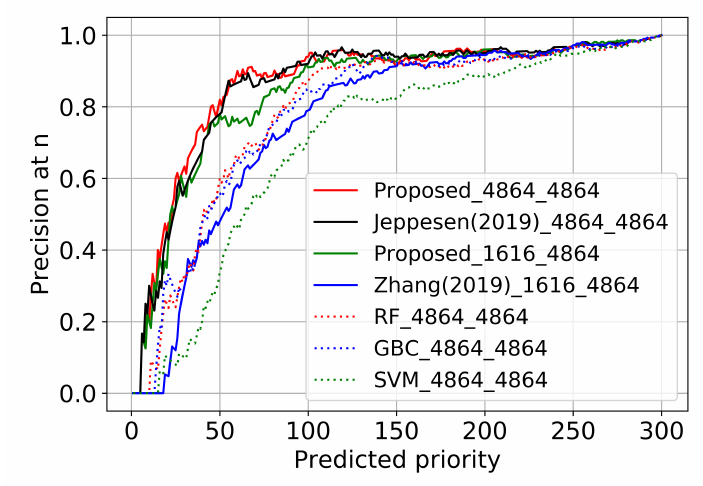
Figure 12. Precision at n for NU-Net (proposed), RS-Net (Jeppesen, 2019), without patch decomposition, and NU-Net (proposed) and L-Unet (Zhang, 2019) with patch decomposition. CNN methods are also compared with classical methods using RF, GBC, and SVM. Spearman’s rank correlation coefficient is ρ NU 4864 = 0.962, ρ RS 4864 = 0.961, ρ RS 1616 = 0.946, ρ LU 1616 = 0.837, ρ RF 4864 = 0.903, ρ GBC 4864 = 0.890, and ρ SVM 4864 = 0.795